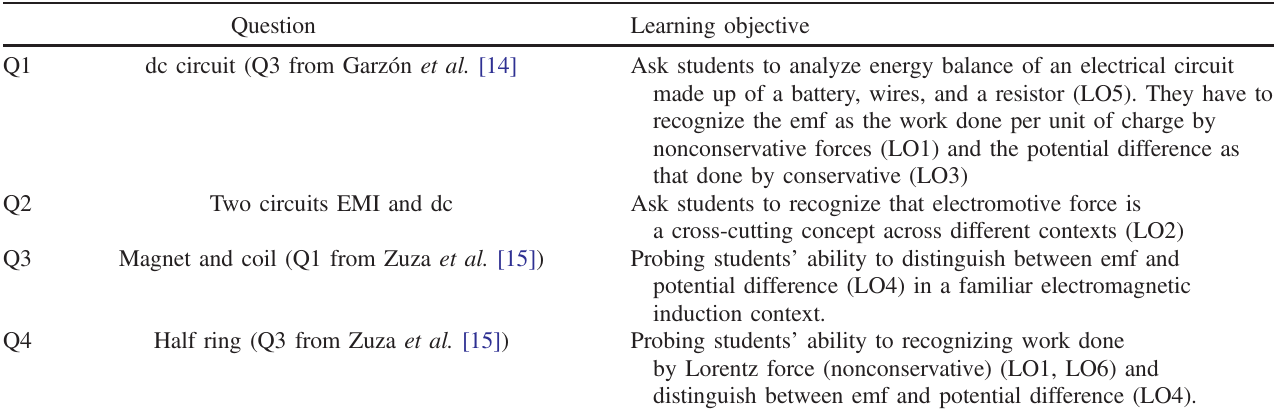
TABLE III. Open ended questions used to analyze students ’ attainment of the learning objectives. See Appendix.